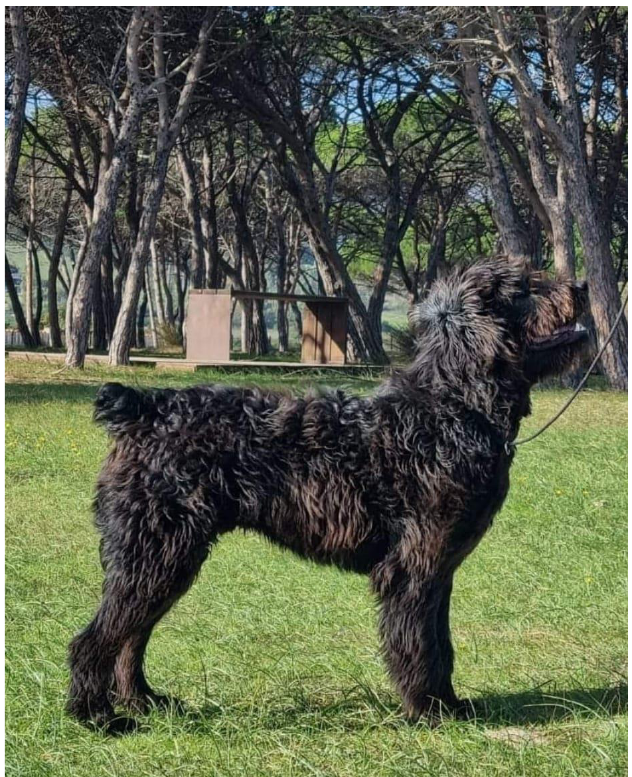
Figure 1. An example of brachyure Fonni’s dog.